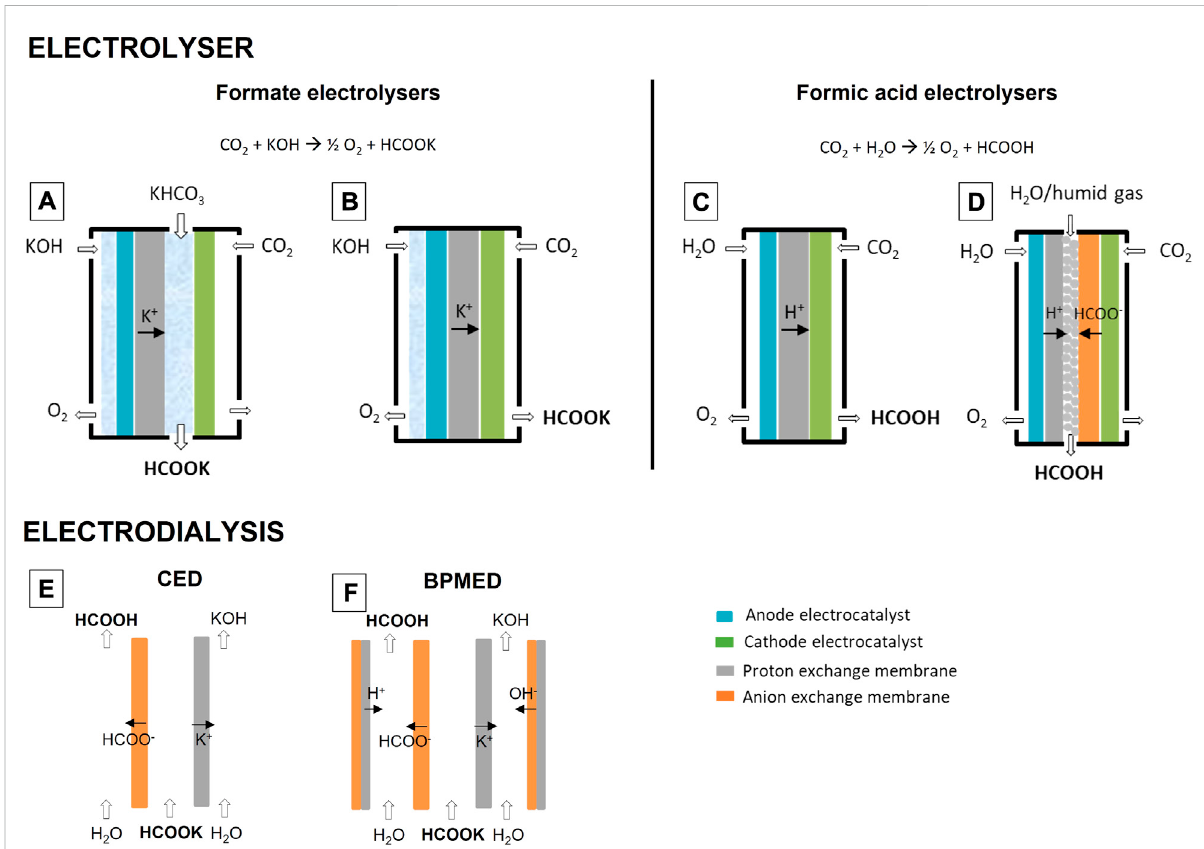
FIGURE 1 Electrolysertypestoproduceaqueouspotassiumformate (A,B) andformicacid (C,D) .Twotypesofelectrodialysisarealsoshown:conventional electrodialysis [ “ CED ” , (E) ] and bipolar membrane electrodialysis [ “ BPMED ” , (F)